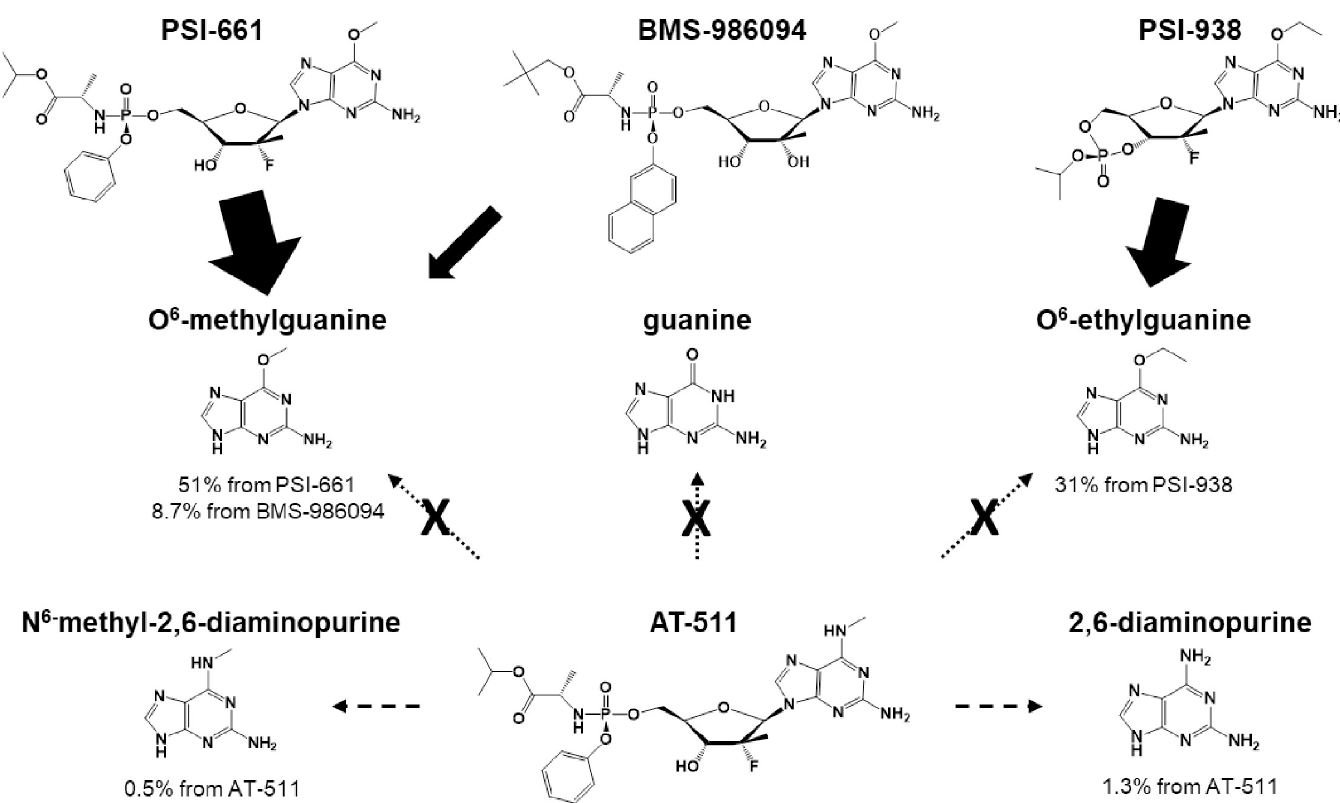
Fig 4. CYP3A4-mediated metabolism of PSI-661, BMS-986094, PSI-938 and AT-511. Values indicate the extent of the 5 μ M starting concentration of each antiviral that was converted to the indicated nucleobase after a 2-h incubation with